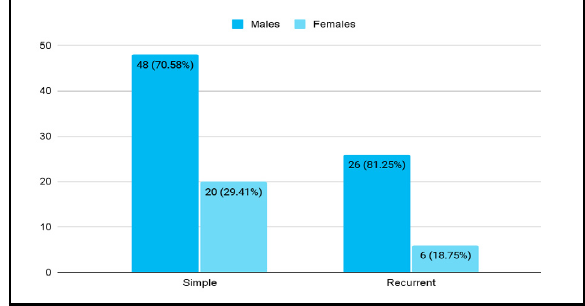
Figure 1. Distribution of febrile convulsion according to gender (n= 100).